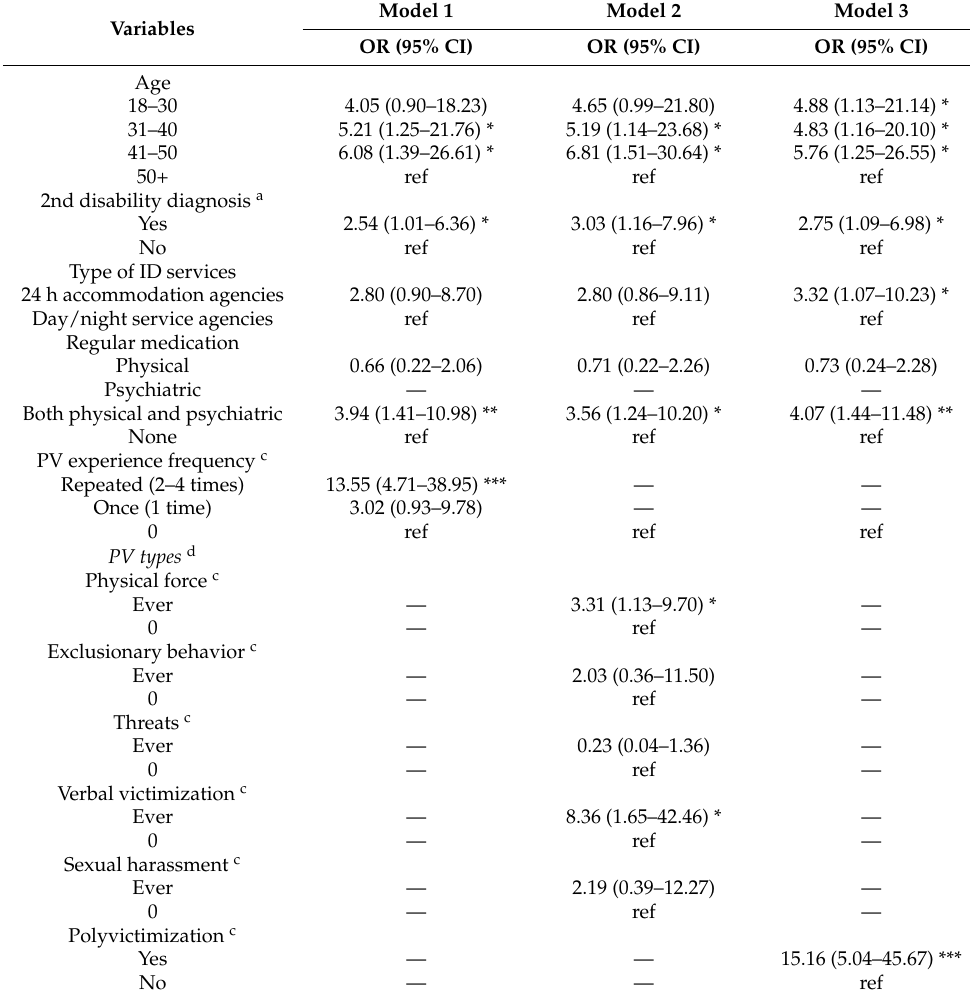
Table 4. Logistic regression analysis of characteristics associated with PIMRA psychiatric